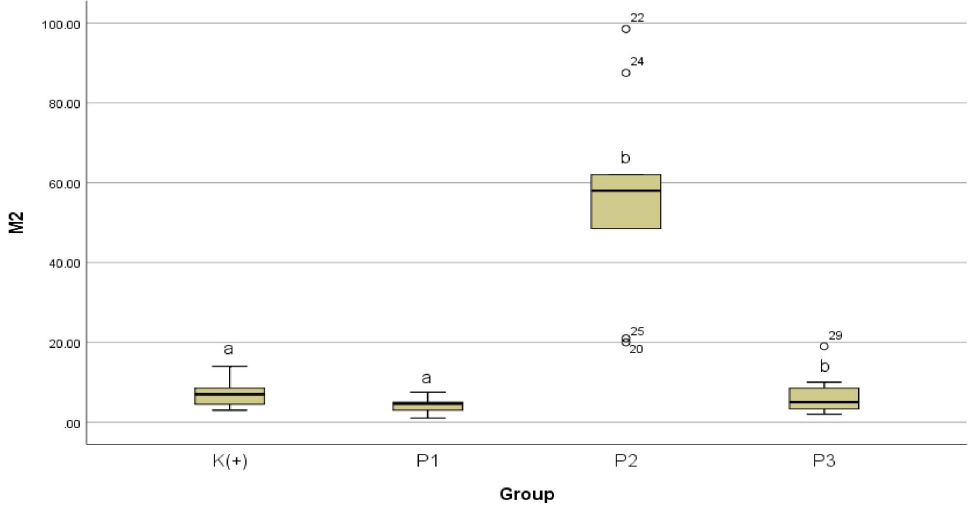
Figure 8. Graph of the median of M2 after giving black cumin